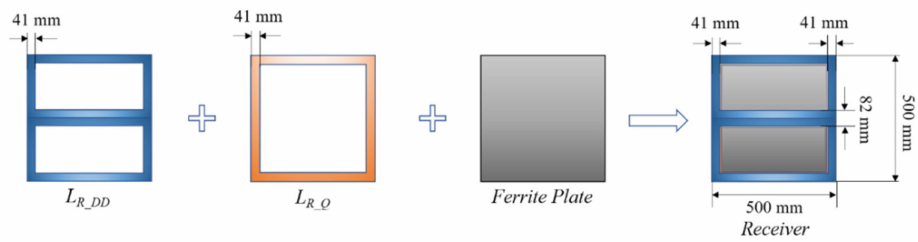
Figure 4. The exploded diagram of the receiver with detailed size information.